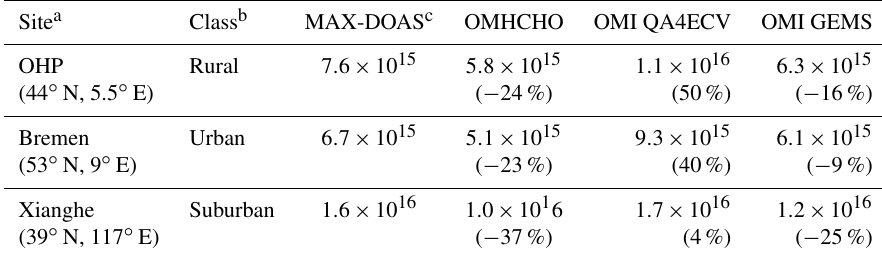
Table 4. Averaged HCHO VCDs (moleculescm − 2 ) from MAX-DOAS ground observations and OMI satellite data at OHP in France, Bremen in Germany, and Xianghe in China. For satellites, mean values are weighted by uncertainties and overlapped areas between satellite pixels and 0.25 ◦ grid cells for each site. Relative differences between OMI and MAX-DOAS are given in parentheses.